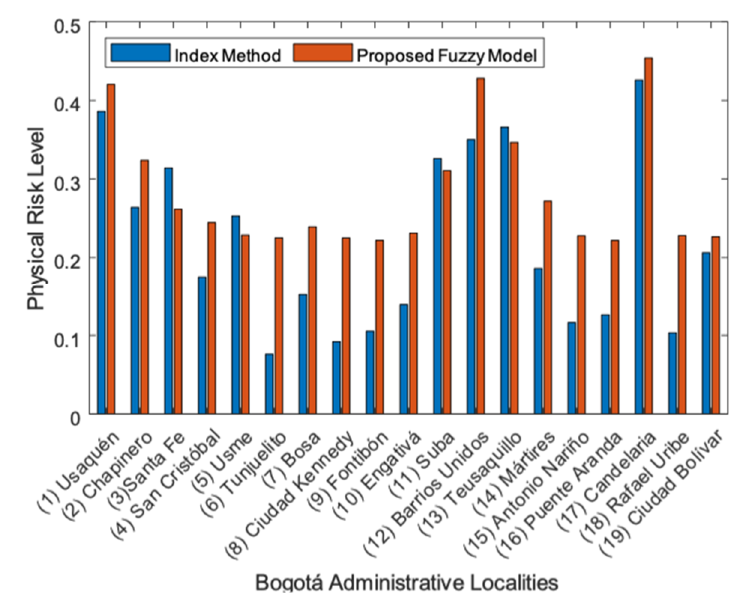
Figure 10. Physical Risk values obtained for the 19 administrative localities of Bogotá with the index method and the proposed fuzzy model.